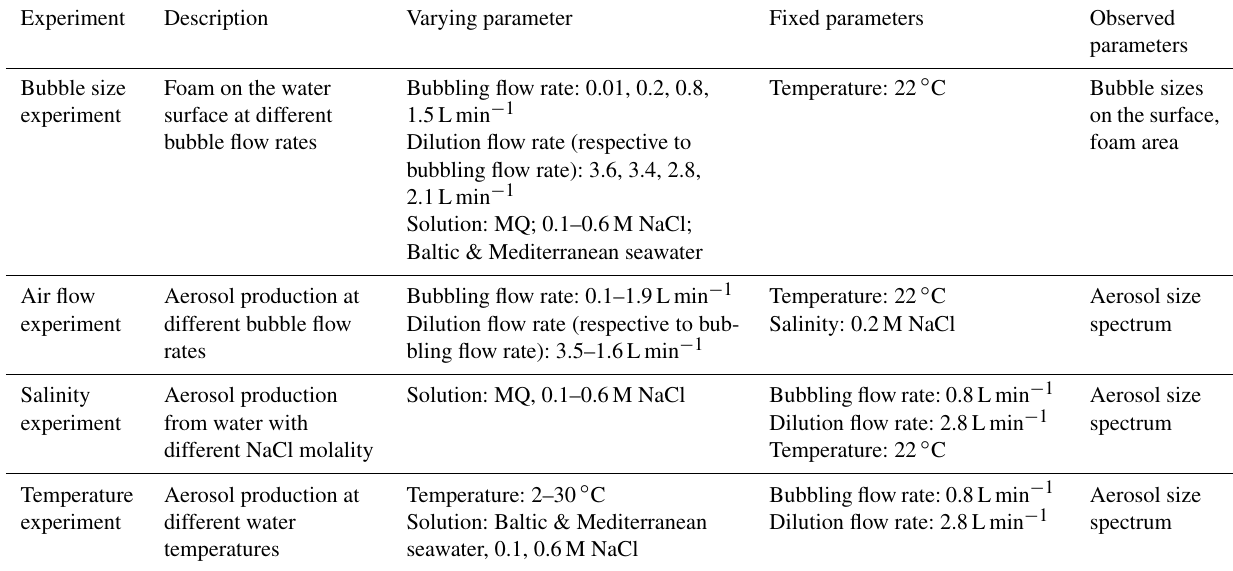
Table 2. Description of